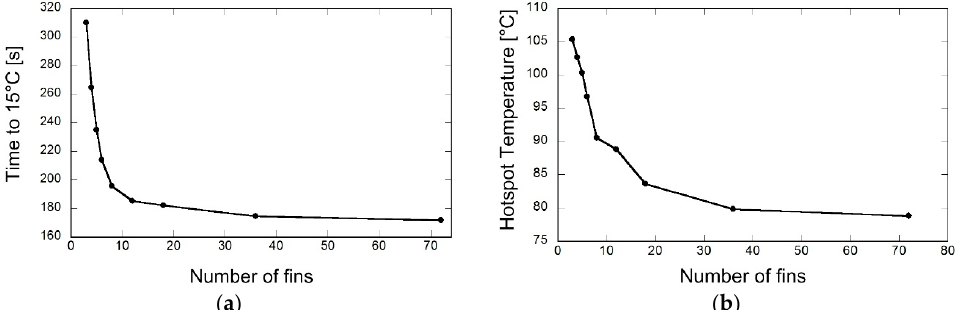
Figure 9. The effect of the number of fins on the reactor with cooling from the external wall as well as the central channel. ( a ) Time required to cool to 15 °C; ( b ) Hot spot temperature. the central channel. ( a ) Time required to cool to 15 ˝ C; ( b ) Hot spot